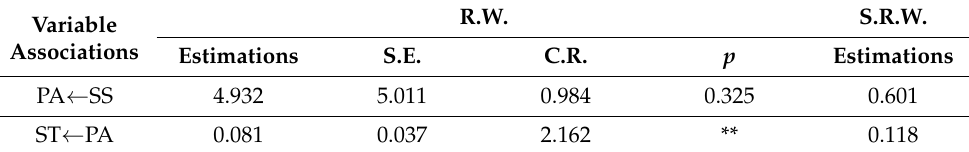
Table 3. Cont . Variable Associations